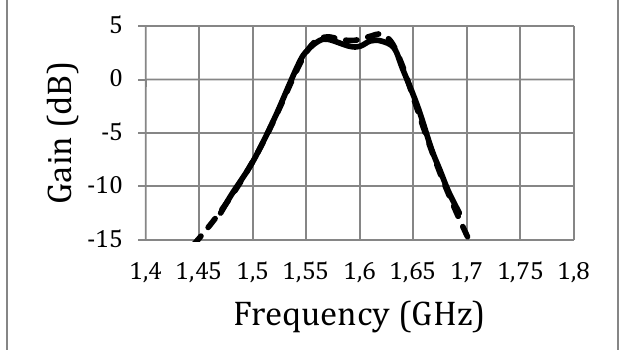
Fig. 10. Gain vs. frequency in the vicinity of the passband: solid – measured, dashed – simulated.